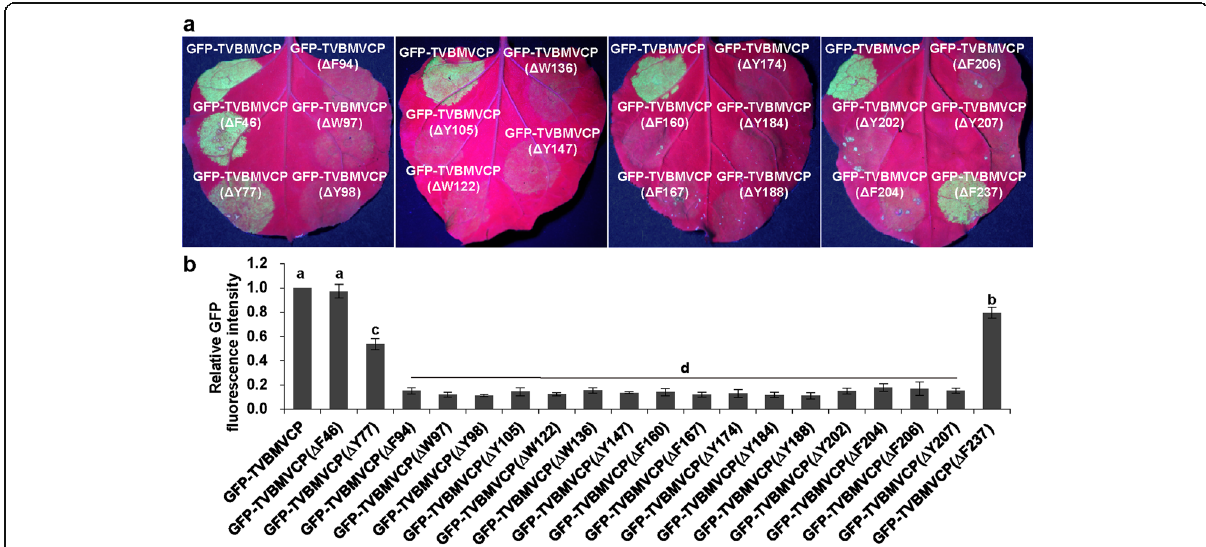
Fig. 2 Effect of π -stackings on CP accumulation. a GFP fluorescence and b relative GFP fluorescence intensities in the N. benthamiana leaf patches expressing GFP-TVBMVCP, one of its 16 mutants derived from aromatic residues (F 94 , W 97 , Y 98 , Y 105 , W 122 , W 136 , Y 147 , F 160 , F 167 , Y 174 , Y 184 , Y 188 , Y 202 , F 204 , F 206 and Y 207 ) that were predicted to form π -stacking, or one of its 3 mutants derived from aromatic residues (F 46 , Y 77 and F 237 ) that could not form π -stacking at 5 dpai. ‘ Δ ’ indicates the codon for the residue was deleted. The values are the means ± SD from three biological replicates per treatment. Treatments marked with the same lowercase letters have no significant statistical